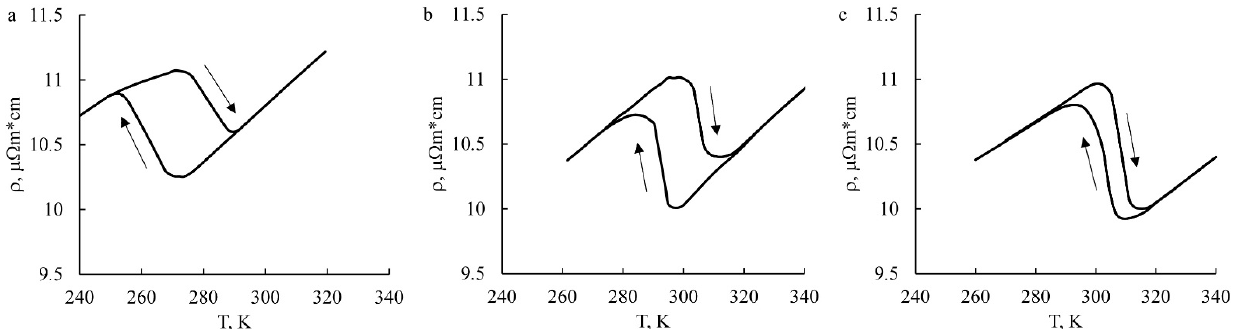
Figure 10. ( a , c ) Bright- and ( b , d ) dark-field TEM images (amplitude contrast) of the microstructure